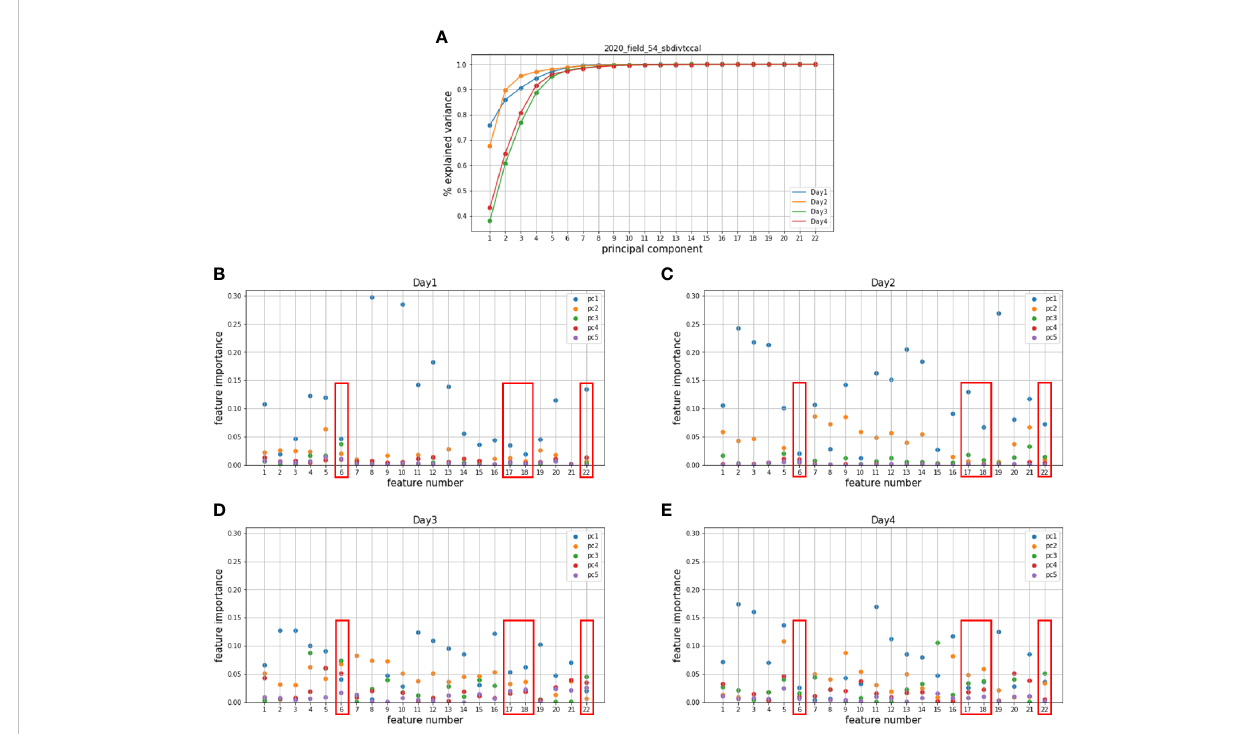
FIGURE 6 Principal components of the hyperspectral features in (A) the 2020 Cal panel and the corresponding importance of all hyperspectral features on (B) the 1st, (C) the 2nd, (D) the 3rd, (E) the 4th dates which represent four different growing